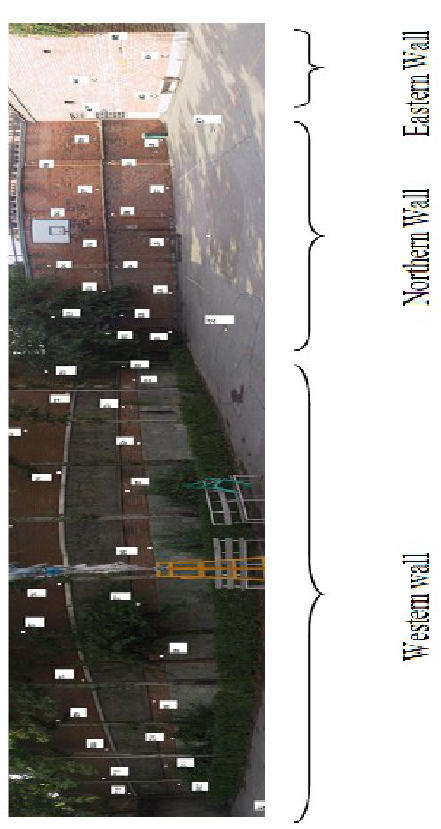
Figure 2: The test area with the location of the targets used